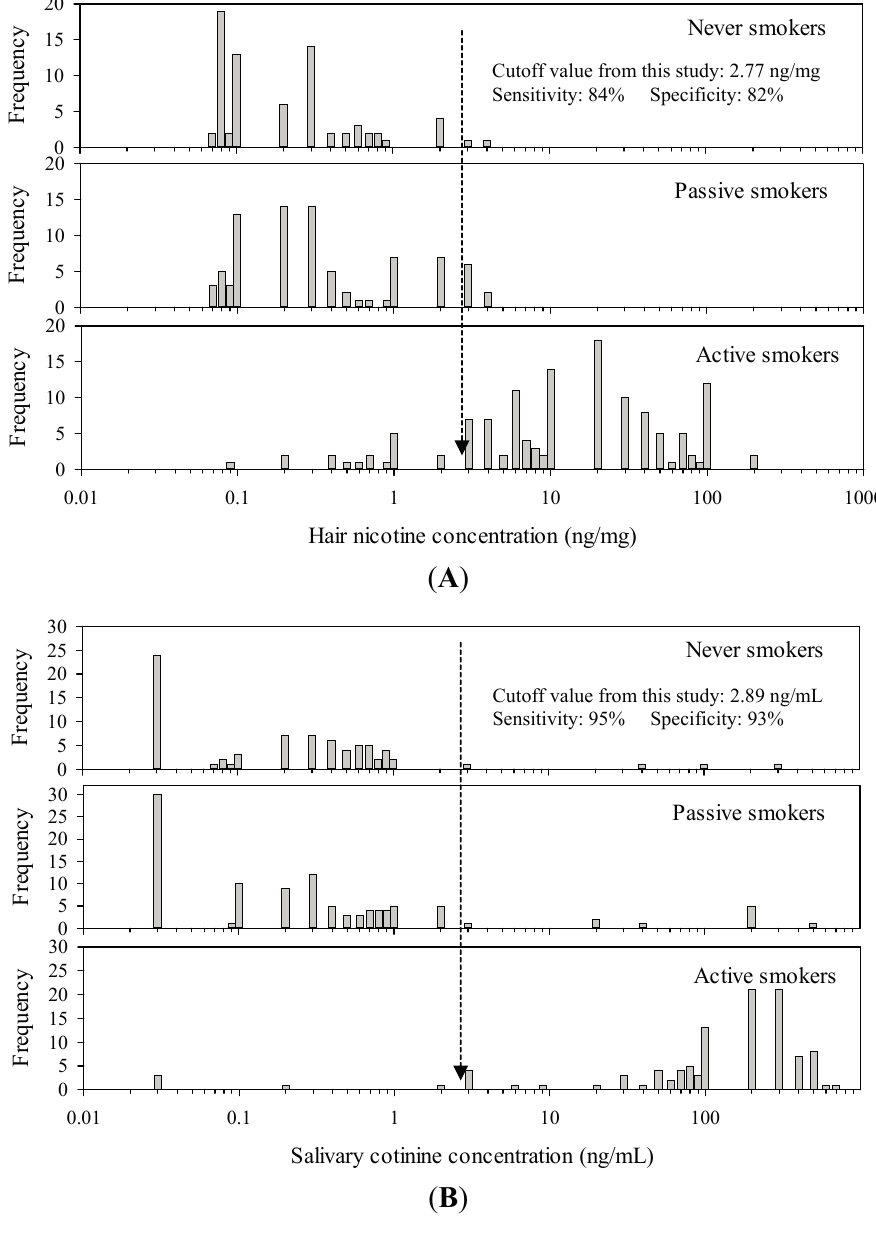
Figure 3. Frequency of ( A ) hair nicotine and ( B ) salivary cotinine concentration(s) by self-reported smoking status and cutoff values distinguishing smokers from nonsmokers and their sensitivities and specificities obtained from ROC